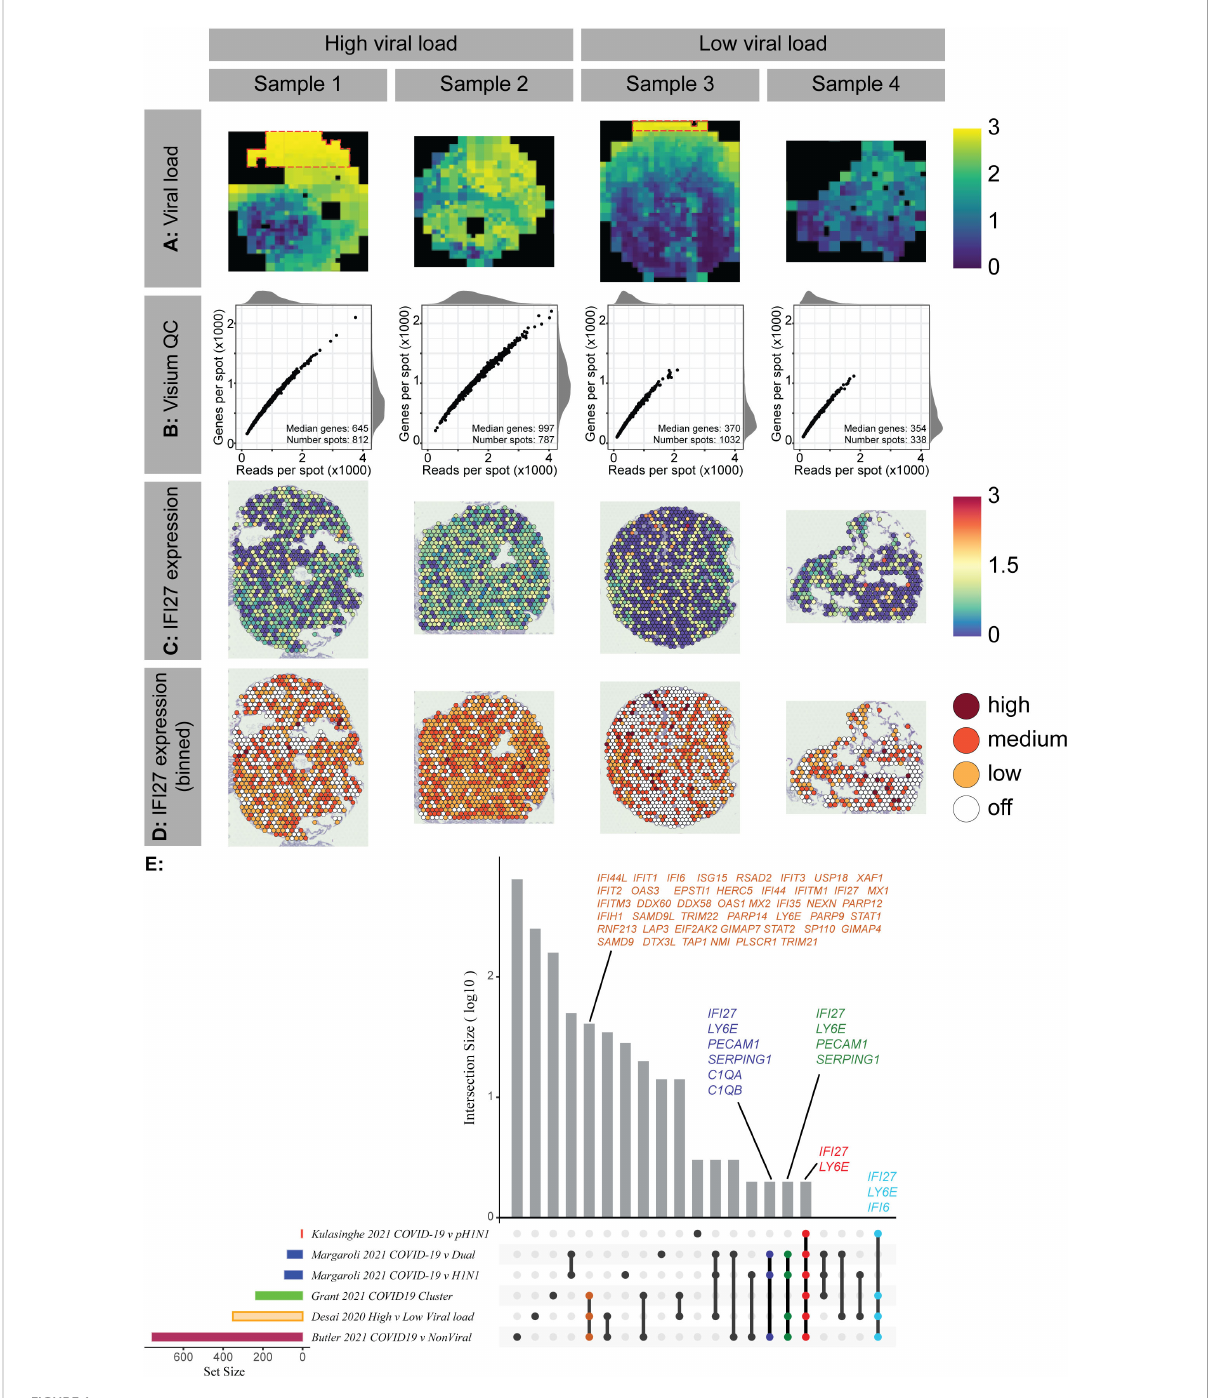
FIGURE 1 Lower airway IFI27 gene expression in COVID-19 patients A In Cohort 1, spatial expression heatmap of normalised COVID-19 RNAscope signal was determined using STRISH analysis. The heatmap colour shows average RNAscope signal per cell per rectangle area that contains a similar number of cells (fewer than 100 cells per rectangle). Red boxes indicate areas of overexposure in the original RNAscope microscopy, which were excluded from the analysis. B Quality metrics of four multiplexed Visium samples, indicating the number of genes and reads per spot with summary statistics. C Normalised expression of IFI27 across four samples measured in the same Visium experimental slide (poly-A protocol) (blue as low and yellow- red as high). D Binned values of normalised expression of IFI27 across Visium samples. E Upset plot describing the overlapping gene sets across 5 studies. The size of the gene set varies across the studies with a small number of common genes including IFI27 shared across all studies